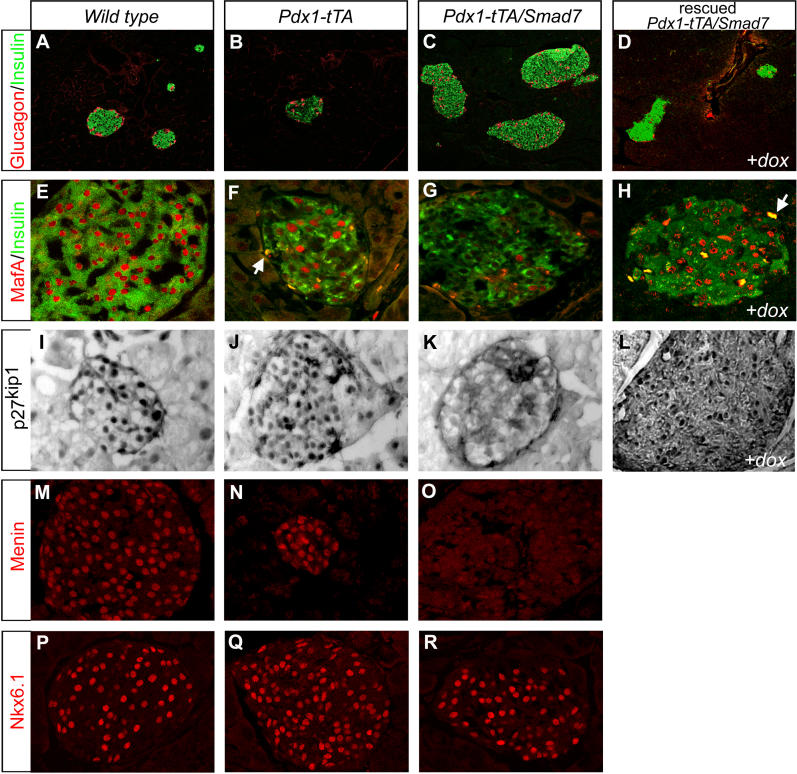
Conditional Smad7 Expression Alters Expression of Factors Important for Maintaining Adult β CellsData are from tissues of male mice aged 4–5 mo.(A–C) Immunofluorescent detection of insulin
+ β cells (green) and glucagon
+ β cells (red) in wild-type,
Pdx1-tTA, and bitransgenic
Pdx1-tTA/Smad7 mice.
(C) Islet enlargement was detected in some bitransgenic
Pdx1-tTA/Smad7 mice following doxycycline withdrawal.
(D) Islet morphology in paraffin sections appeared normal in bitransgenic
Pdx1-tTA/Smad7 animals 5 wk after readministration of doxycycline, as described in
Materials and Methods.
(E–H) Smad7 alters expression of MafA (red) in β cells expressing insulin (green).(F and G) The number of MafA-expressing β cells in bitransgenic
Pdx1-tTA/Smad7 was reduced compared to controls (
n = 3).
(E and F)
Pdx1-tTA animals also showed a mild decrease in numbers of MafA expressing islet cells relative to wild-type controls.
(H) After diabetic bitransgenic
Pdx1-tTA/Smad7 animals were readministered doxycycline (+
dox), islet MafA expression appeared normal. Staining was performed on paraffin sections.
(I–K, M–O) The expression of nuclear p27
kip1 (black, I–K) and Menin (red, M–O) was reduced in adult
Pdx1-tTA/Smad7 animals compared to wild-type and
Pdx1-tTA controls (
n = 5).
(L) After diabetic bitransgenic
Pdx1-tTA/Smad7 animals were readministered doxycycline (+
dox), p27
kip1 expression appeared relatively normal.
(P–R) Nkx6.1 expression (red) was unchanged in
Pdx1-tTA/Smad7 animals. Arrows in (H) and (F) mark autofluorescent blood cells. Original magnification is 20× (A–D, I–L), and 63× (E–H, M–R).